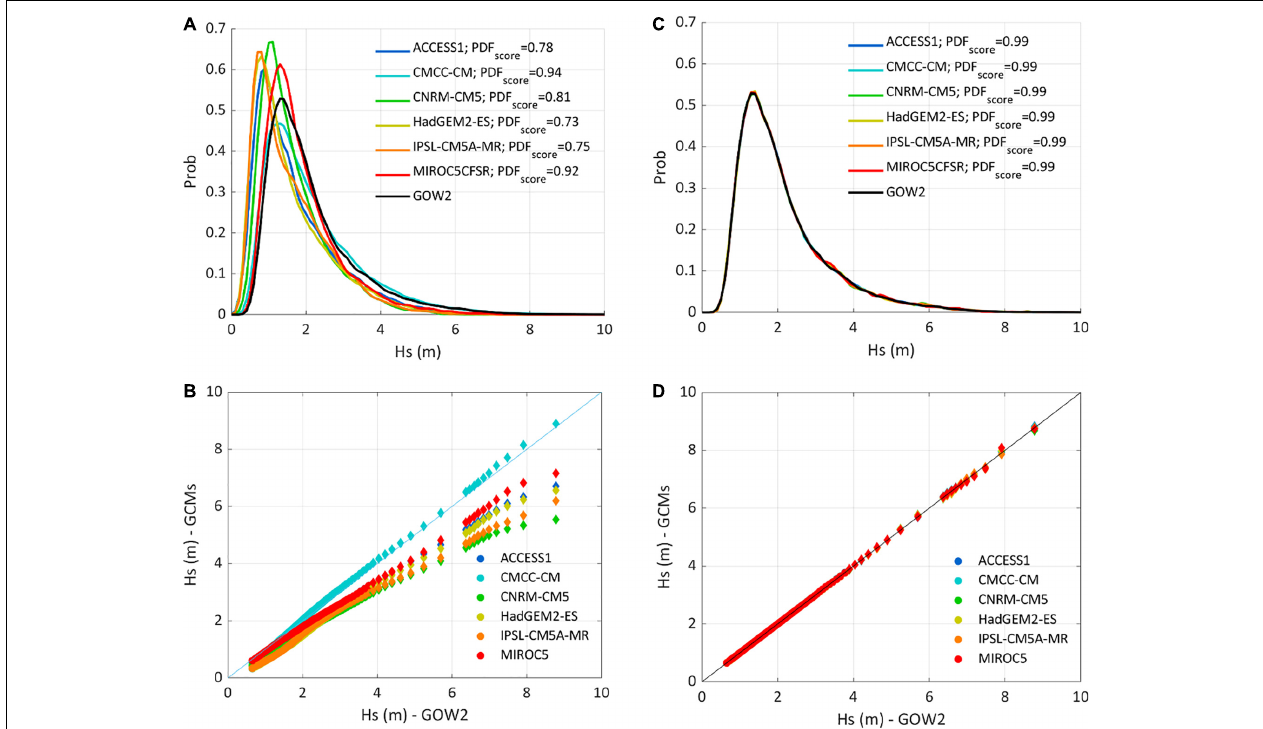
FIGURE 3 | (A) Probability distribution function of Hs at deep waters from the hindcast GOW2 database and the uncorrected climatic data from each ensemble member (i.e., ACCESS1.0, CMCC-CC, CNRM-CM5, HadGEM2-ES, IPSL-CM5A-MR, and MIROC5) with the corresponding PDFscore. (B) Q–Q plot of the original uncorrected Hs, per ensemble member. (C) Probability distribution functions of GOW2 Hs and corrected Hs associated with each ensemble member. (D) Q–Q plot of the original uncorrected Hs, per ensemble member.